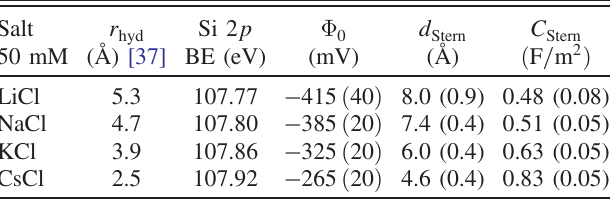
Table II. Hydrated cation radii, Si 2 p binding energies and properties of the electrical double layer.